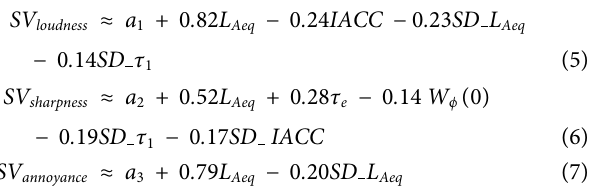
Frontiers in Built Environment |